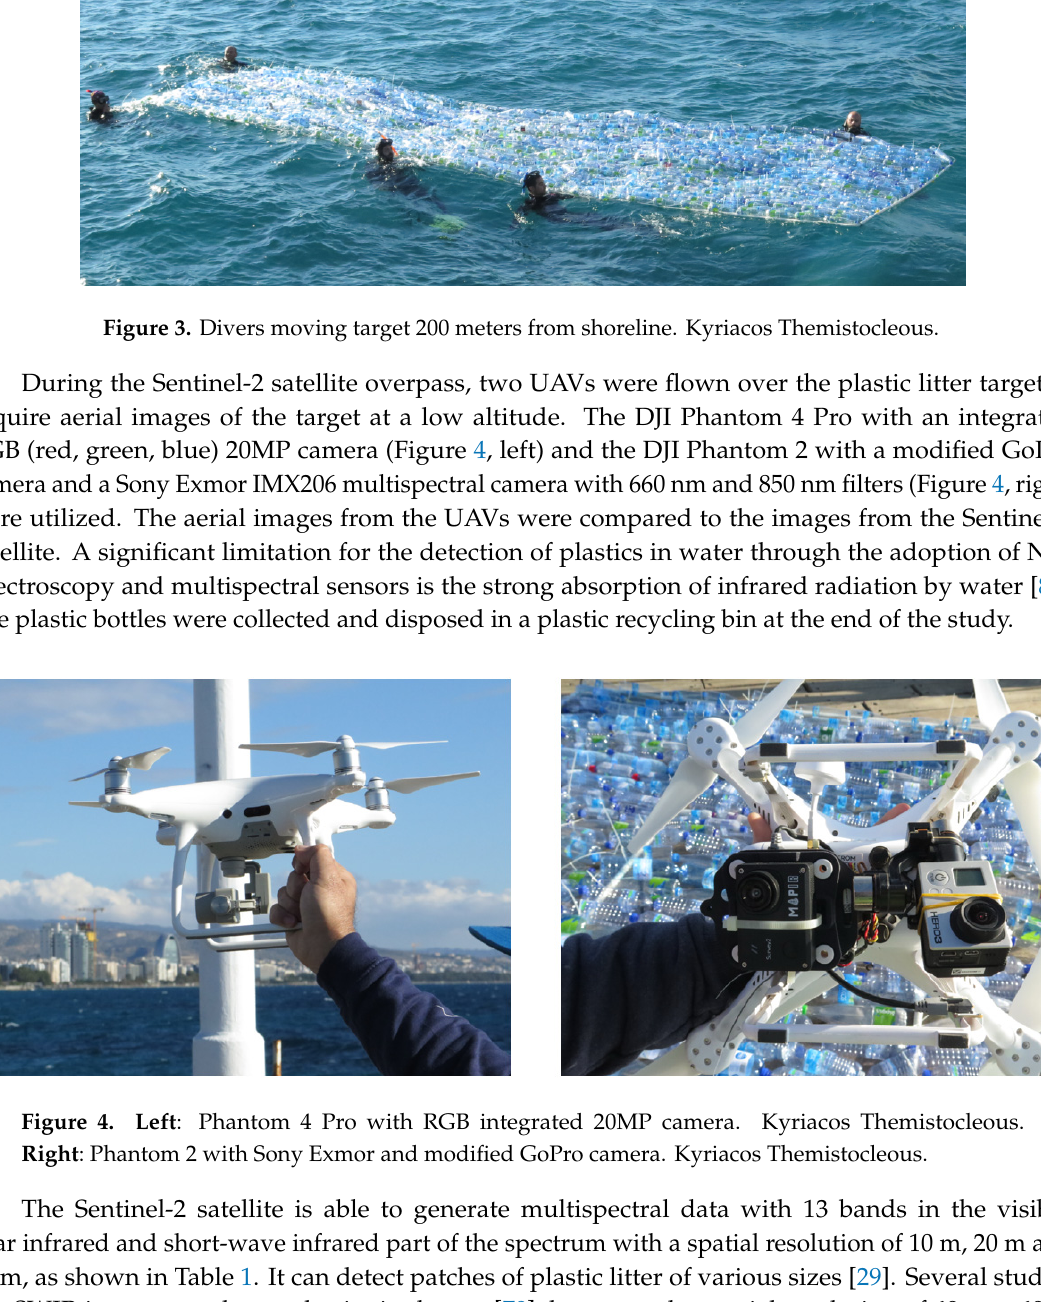
Figure 3. Divers moving target 200 meters from shoreline. Kyriacos Themistocleous.